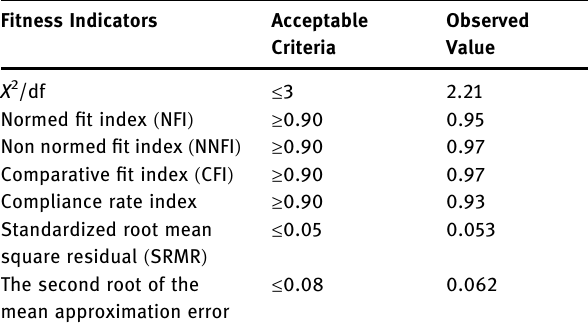
Table 7: Results of the degree of compliance of the research model with fi tness indicators